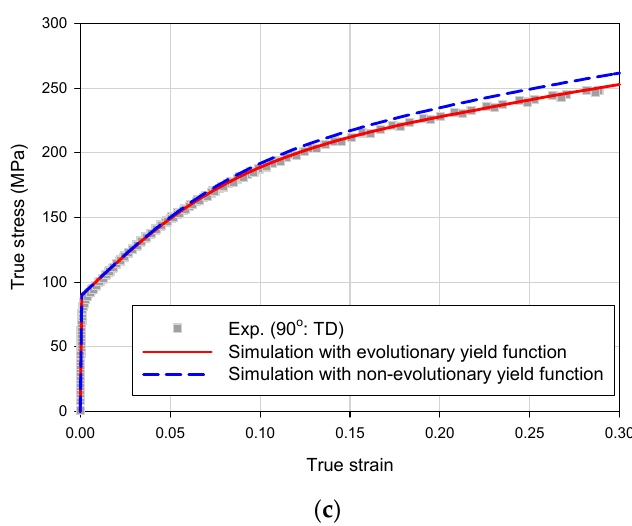
Figure 16. Comparison of the measured and simulated true stress–strain curves for ( a ) 0, ( b ) 45 and ( c ) 90 degrees off tensile directions for the niobium sheet.